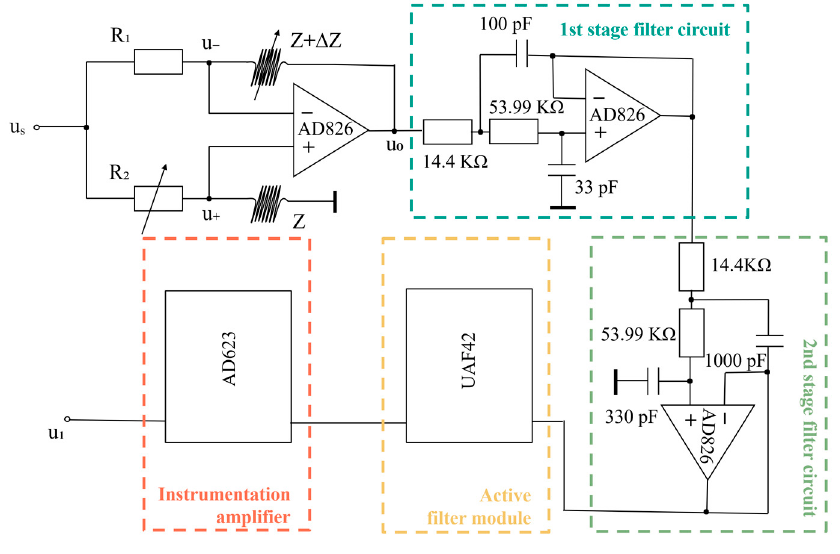
Figure 7. Schematic diagram of signal processing circuit.